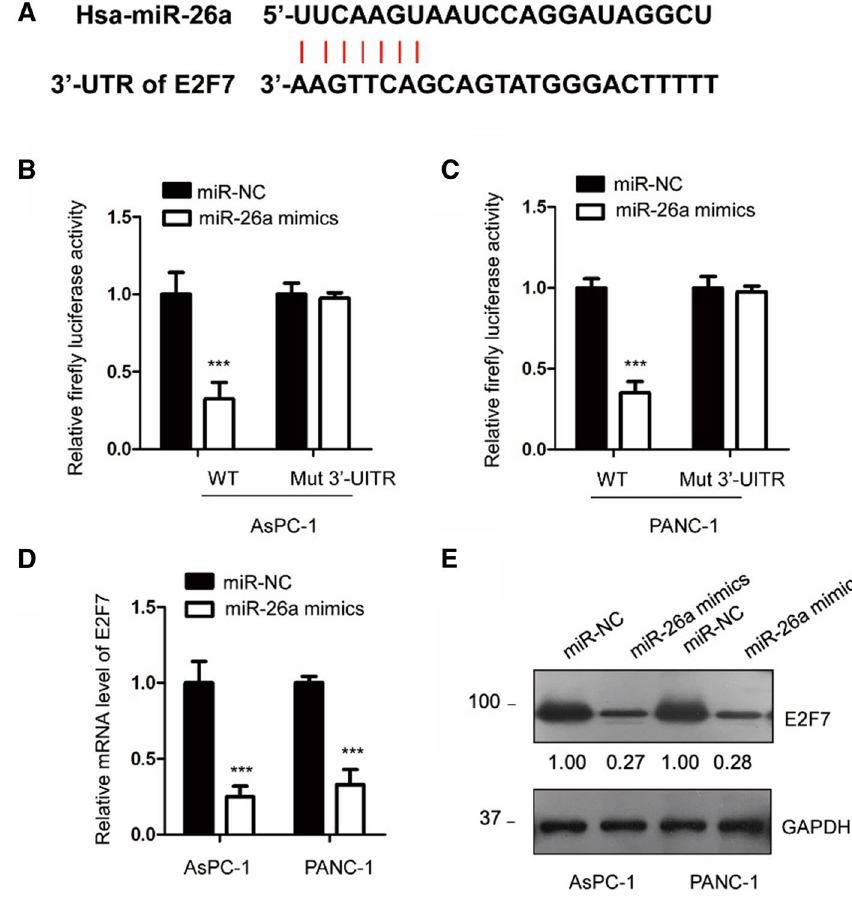
Fig. 3 miR-26a targeted E2F7 in PCa. A The possible binding site of miR-26a in the 3’-UTR of E2F7 mRNA. B , C The luciferase activity of AsPC-1 and PANC-1 cells that were co- transfected with miR-26a and either vector expressing WT or Mut 3’-UTR of E2F7. D , E We detected the mRNA or protein expression of E2F7 in PCa cells that were overexpressed with miR-26a. *** P <